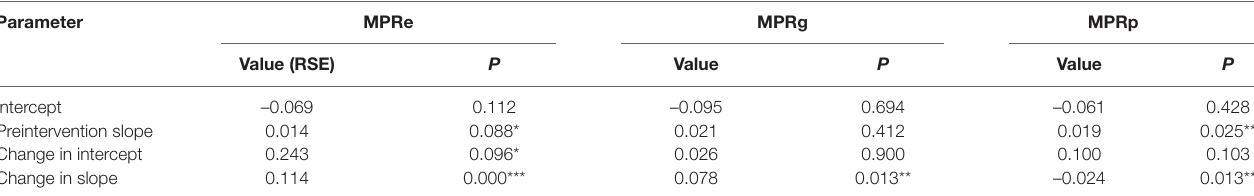
TABLE 3 | Estimated coefficients of segmented regression models for the MPRe, MPRg, and MPRp before and after the NPMPP, Shaanxi Province, February 2015 to December 2017. Parameter